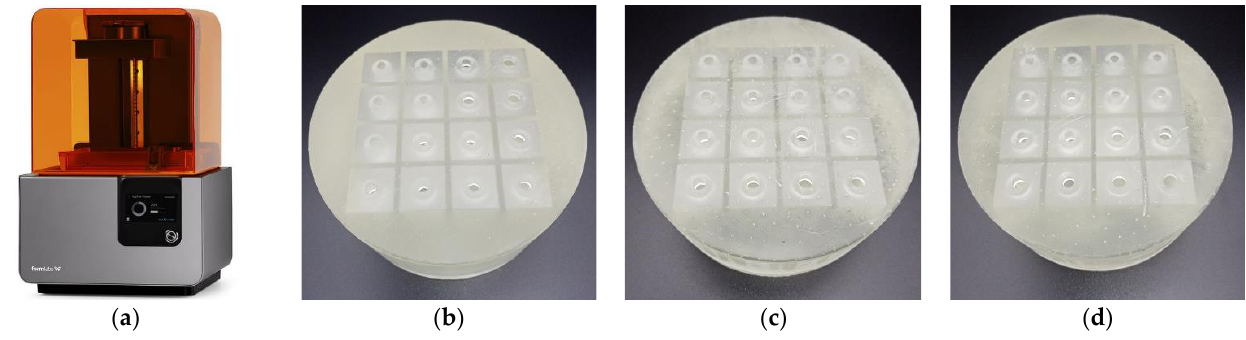
Figure 9. Preparation of experimental samples: ( a ) the utilized 3D printer; ( b ) sample for the condition–1; ( c ) sample for the condition–2; ( d ) sample for the condition–3.